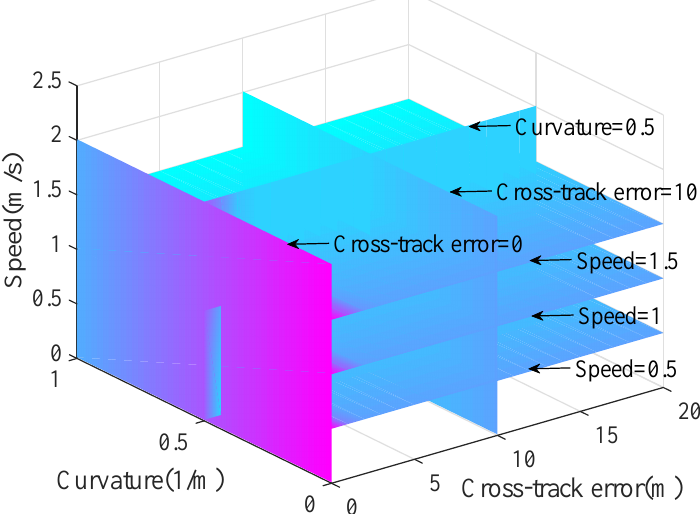
Figure 10. Relationship between look-ahead and